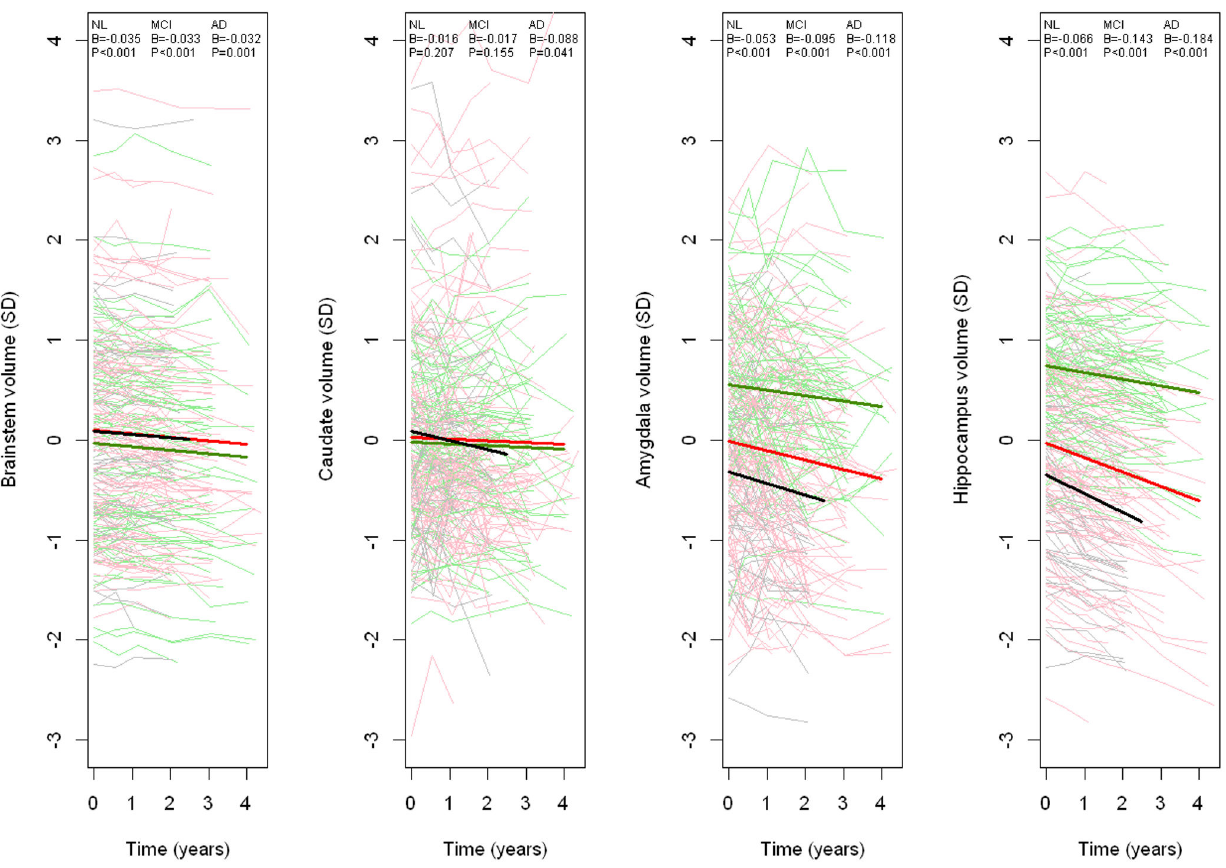
Figure 1. Longitudinal volume changes in a priori defined regions. Y-axes show volumes and x-axes show time from study onset. The thin lines are observed volumes (standardized) in NL (green), MCI (red), and AD (black). The thick lines are fitted using linear mixed effects models with time as fixed effects, adjusted for age, APOE and sex, modeled within each diagnostic group. B- coefficients and p-values are presented for the time